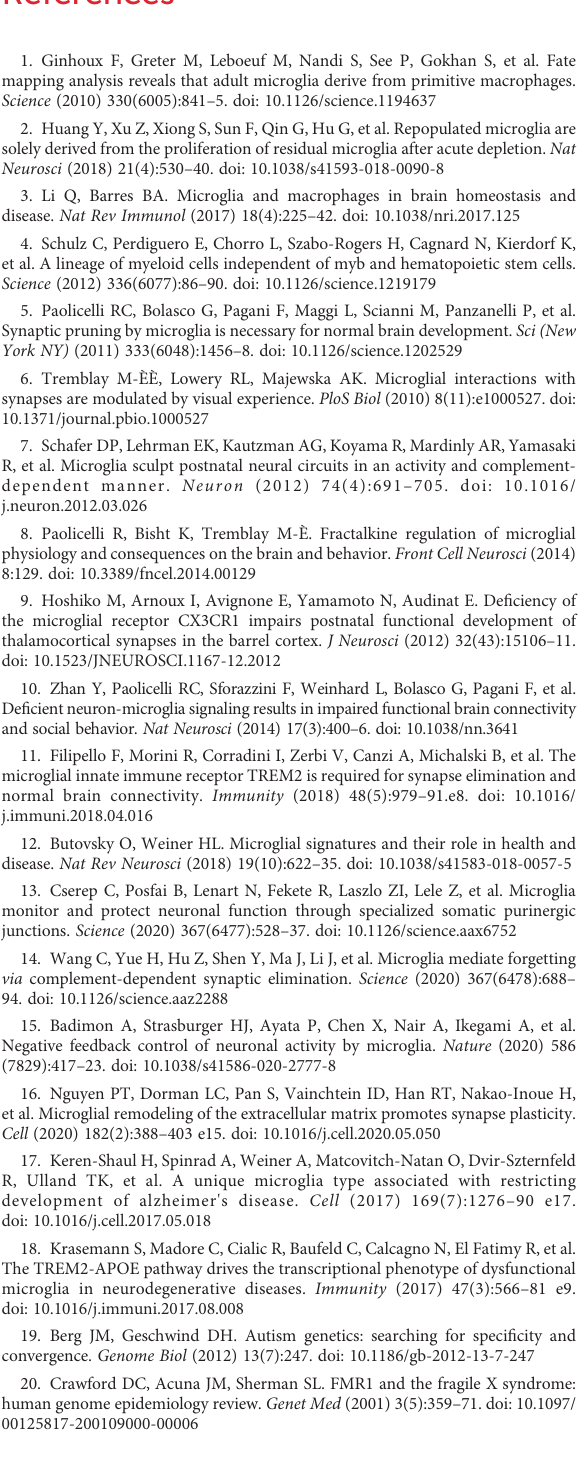
SUPPLEMENTARY TABLE 3 The differentially expressed genes between mPTEN WT(14) and mPTEN KO (14) microglia isolated from 2-3 month